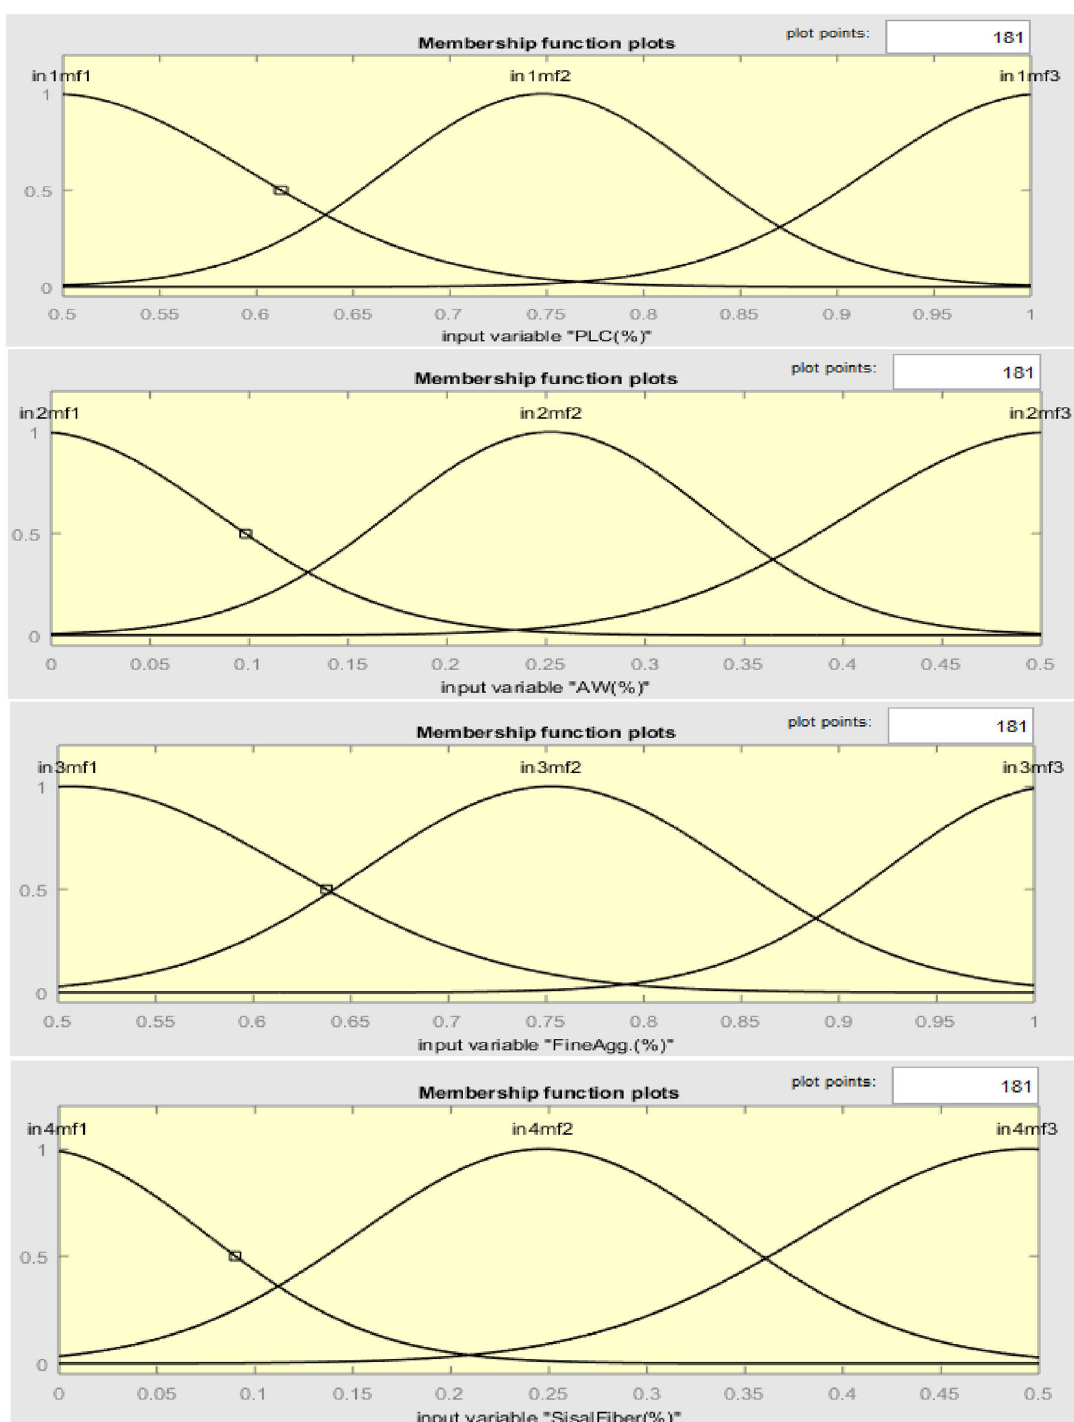
Figure 18. Membership function plots of model